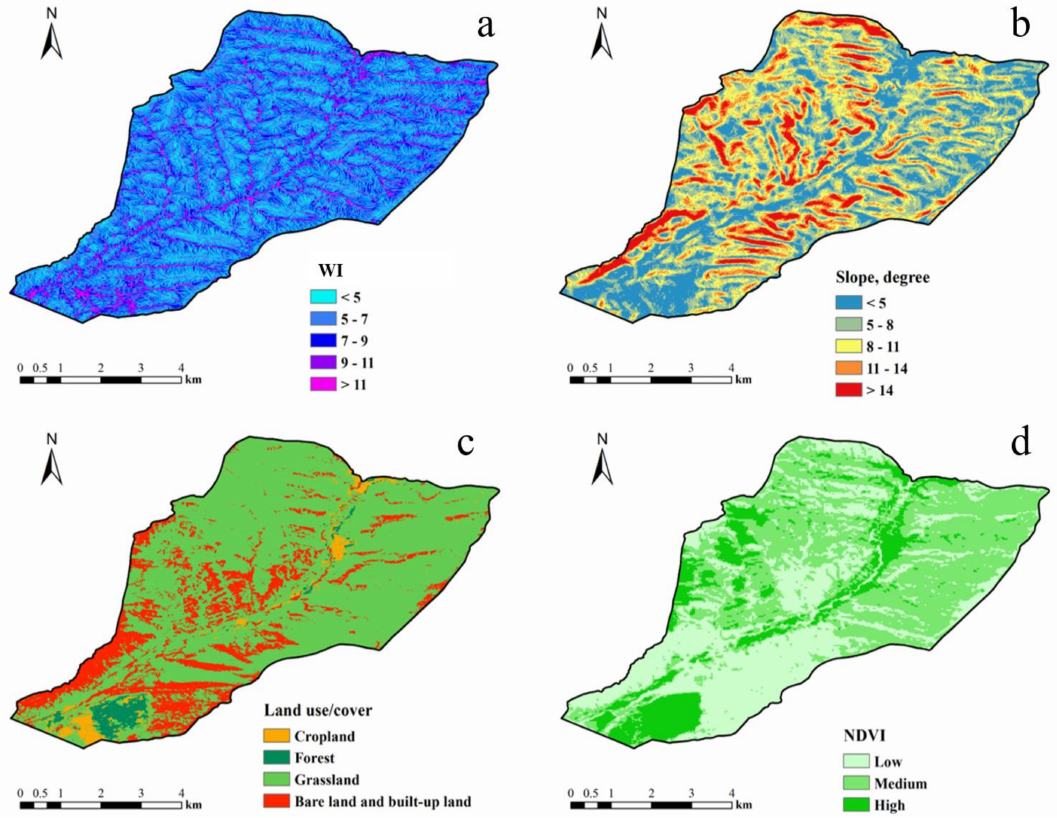
Figure 3. Environmental factors of catchment. ( a ) wetness index (WI); ( b ) slope; ( c ) land use / cover; ( d ) normalized di ff erence vegetation index